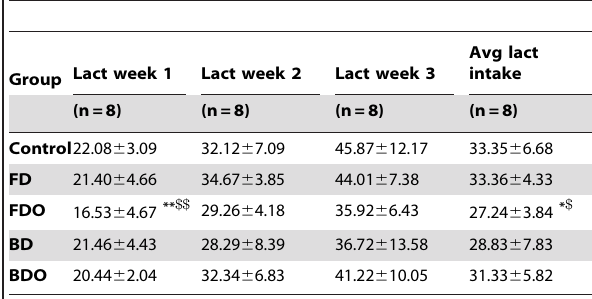
Table 2. Intakes (g) of animals in different groups during lactation period.